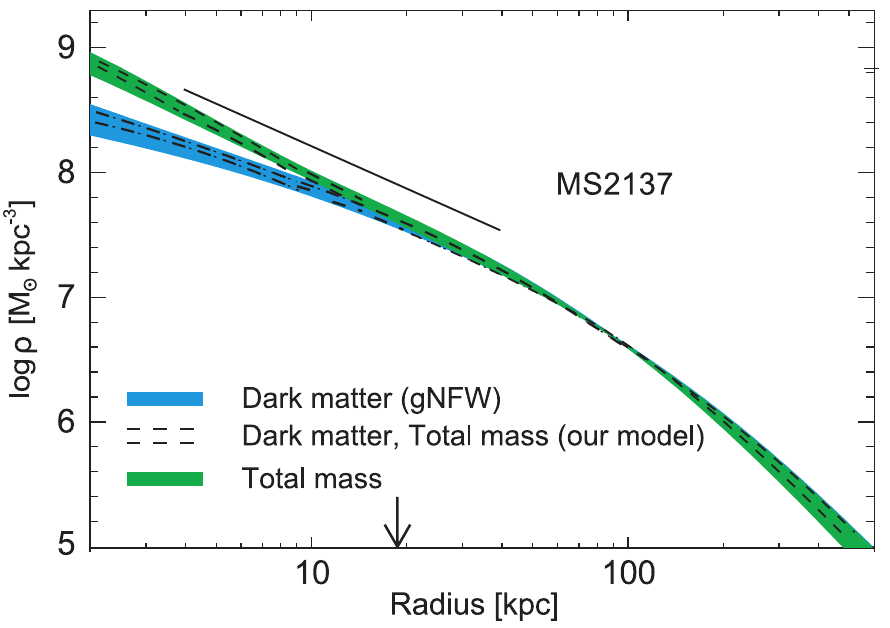
Fig. 1. Density pro(cid:12)le of the total mass and DM for MS2137. The blue and green bands represent the DM and the total mass density pro(cid:12)les determined by N13b. The band in black dotted lines is the DM density pro(cid:12)le obtained in this paper. The band widths represent the 1 (cid:27) uncertainty. The bottom arrow is the three-dimensional half- light radius of the BCG. The segment with the slope r (cid:0) 1 : 13 spans the radial range r = 0 : 003 (cid:0) 0 : 03 r 200